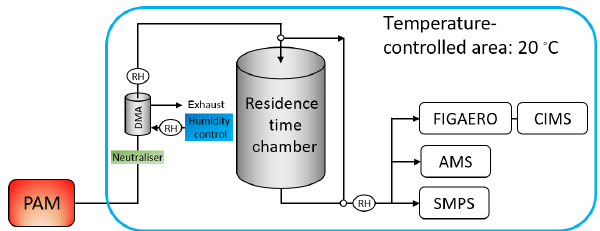
Figure 1. Schematic diagram of experimental